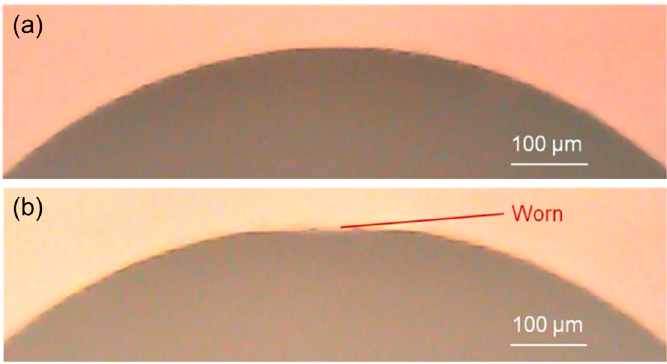
Figure 11. Shape changes on the polisher’s head ( a ) before polishing and ( b ) after polishing.